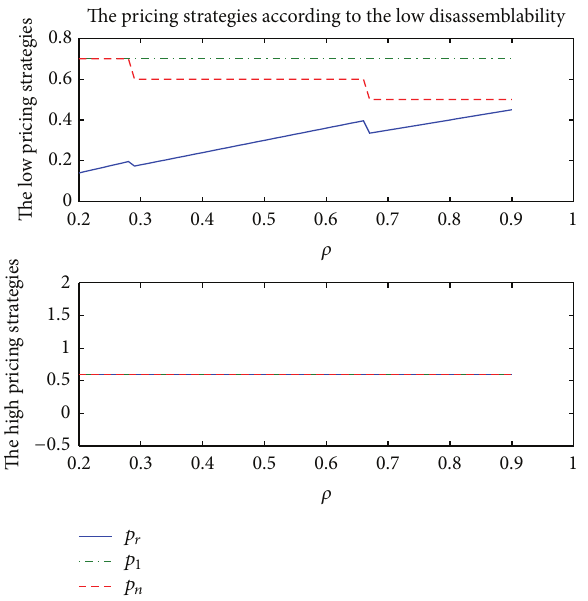
Figure 1: The pricing strategy according to the high disassemblabil- ity.